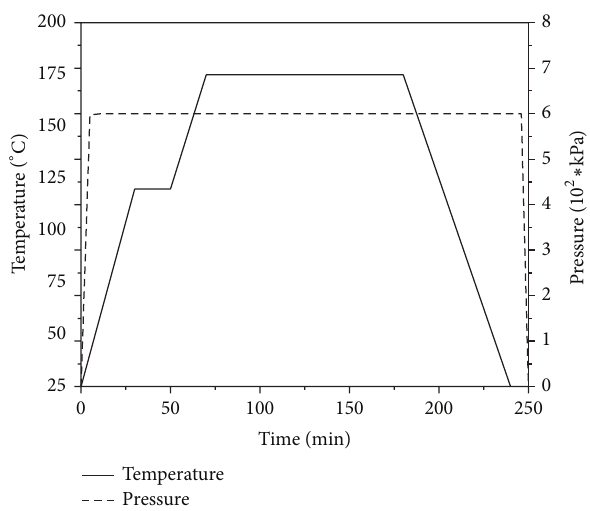
Figure 2: Typical diagram of temperature and pressure profile for curing in a clave [14].